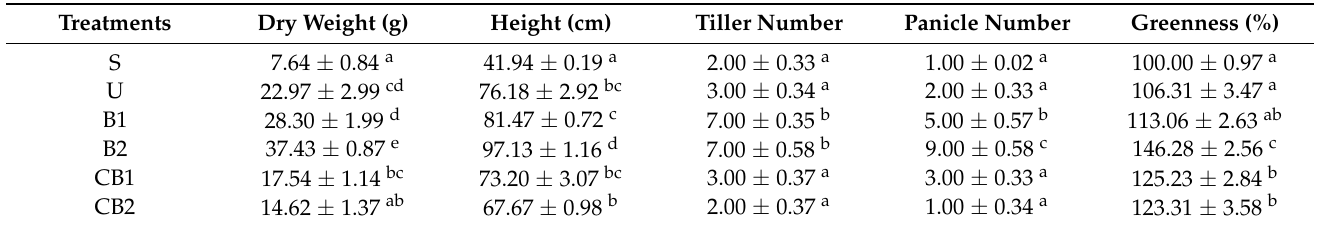
Mean values within column with different letter(s) indicate significant difference between treatments by Tukey’s test at p ≤ 0.05. Columns represent the mean values ± SE. The treatments evaluated were: S: Soil only, U: Soil + 175 kg ha − 1 urea, B1: Soil + 175 kg ha − 1 urea + 5 t ha − 1 rice